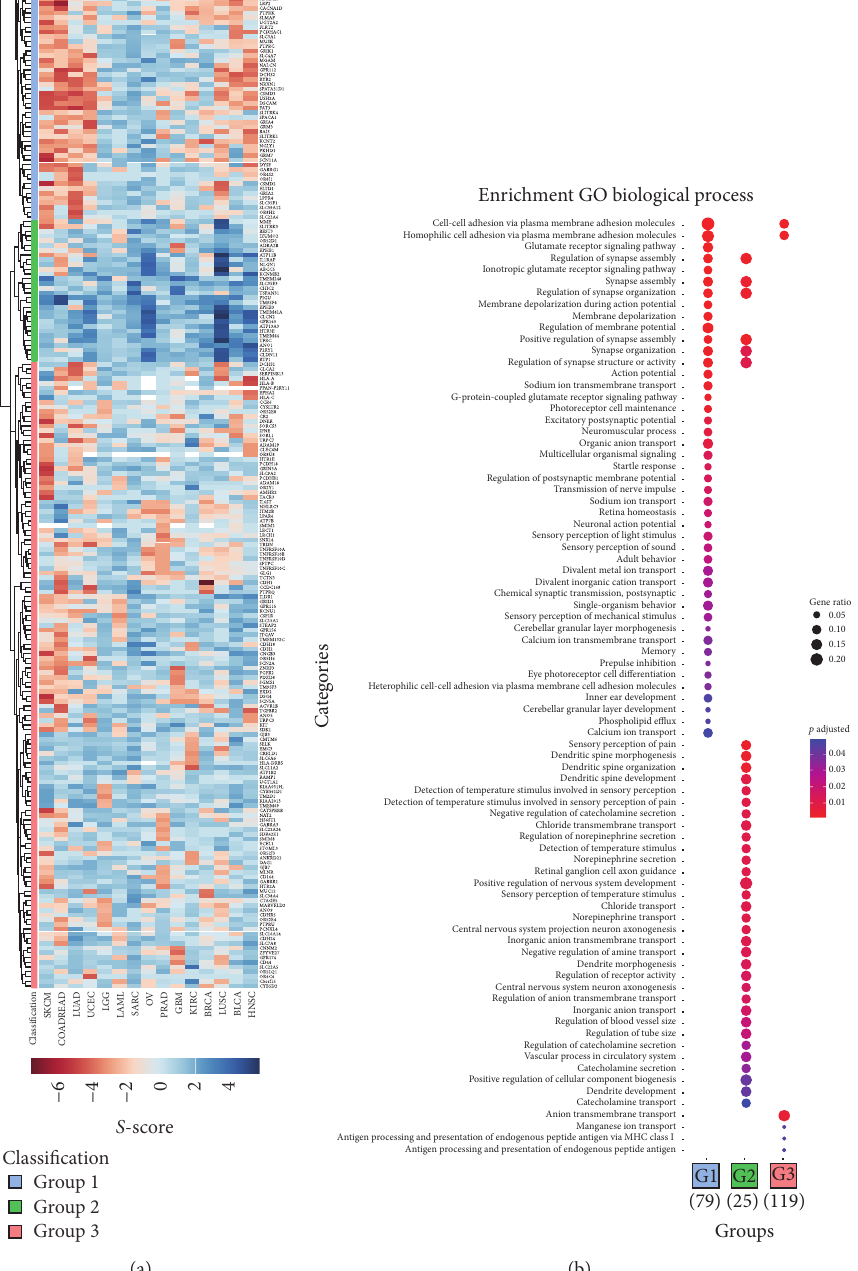
Figure 2: Surfaceome cancer genes identified by the 𝑆 -score method. (a) Heatmap representation of all 248 surfaceome cancer genes for all 15 tumor types. The 𝑆 -score distribution is represented as a range of colors (red as negative 𝑆 -score, blue as positive 𝑆 -scores). Tumor types are SKCM (Skin Cutaneous Melanoma), COADREAD (Colorectal Adenocarcinoma), LUAD (Lung Adenocarcinoma), UCEC (Uterine Corpus Endometrial Carcinoma), LGG (Low Grade Glioma), LAML (Acute Mieloid Leukemia), SARC (Sarcoma), OV (Ovarian Serous Carcinoma), PRAD (Prostate Adenocarcinoma), GBM (Glioblastoma), KIRC (Kidney Renal Clear Cell Carcinoma), BRCA (Breast Invasive Carcinoma), LUSC (Lung Squamous Cell Carcinoma), BLCA (Bladder Adenocarcinoma), and HSNC (Head-Neck Squamous Cell Carcinoma). (b) GO enrichment analysis for the three groups of genes as identified in (Figure 2(a)). The adjusted 𝑝 values are sorted from least (blue) to most (red) significant. Furthermore, the dot size is based on gene ratio, which is the observed number of genes in the experimental set within the respective gene ontology